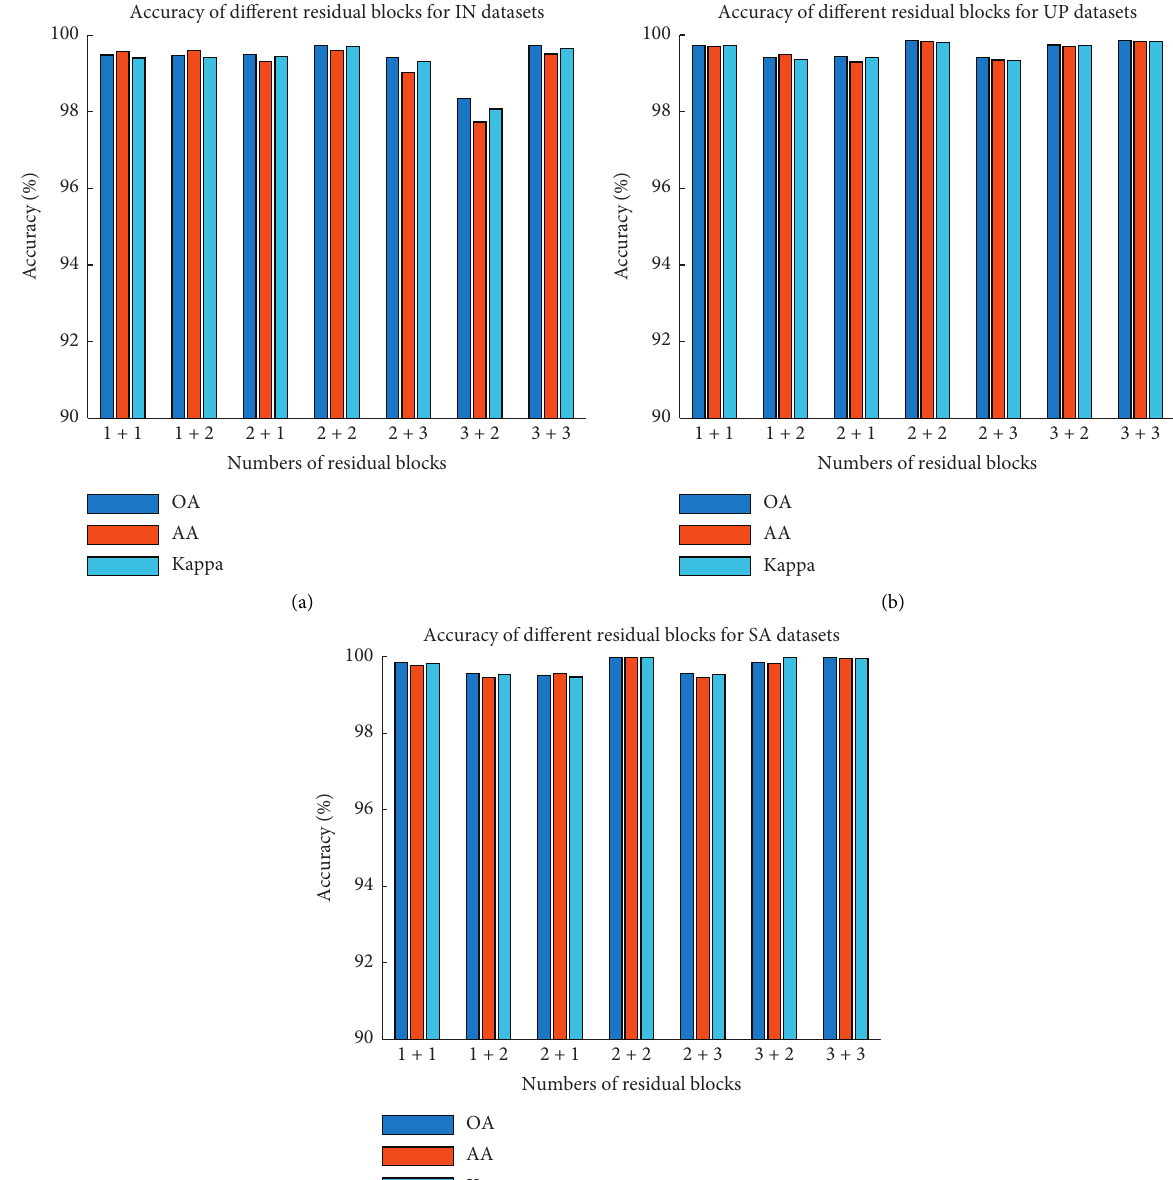
Figure 11: Accuracy comparison chart of different combinations: (a) IN; (b) UP; (c)